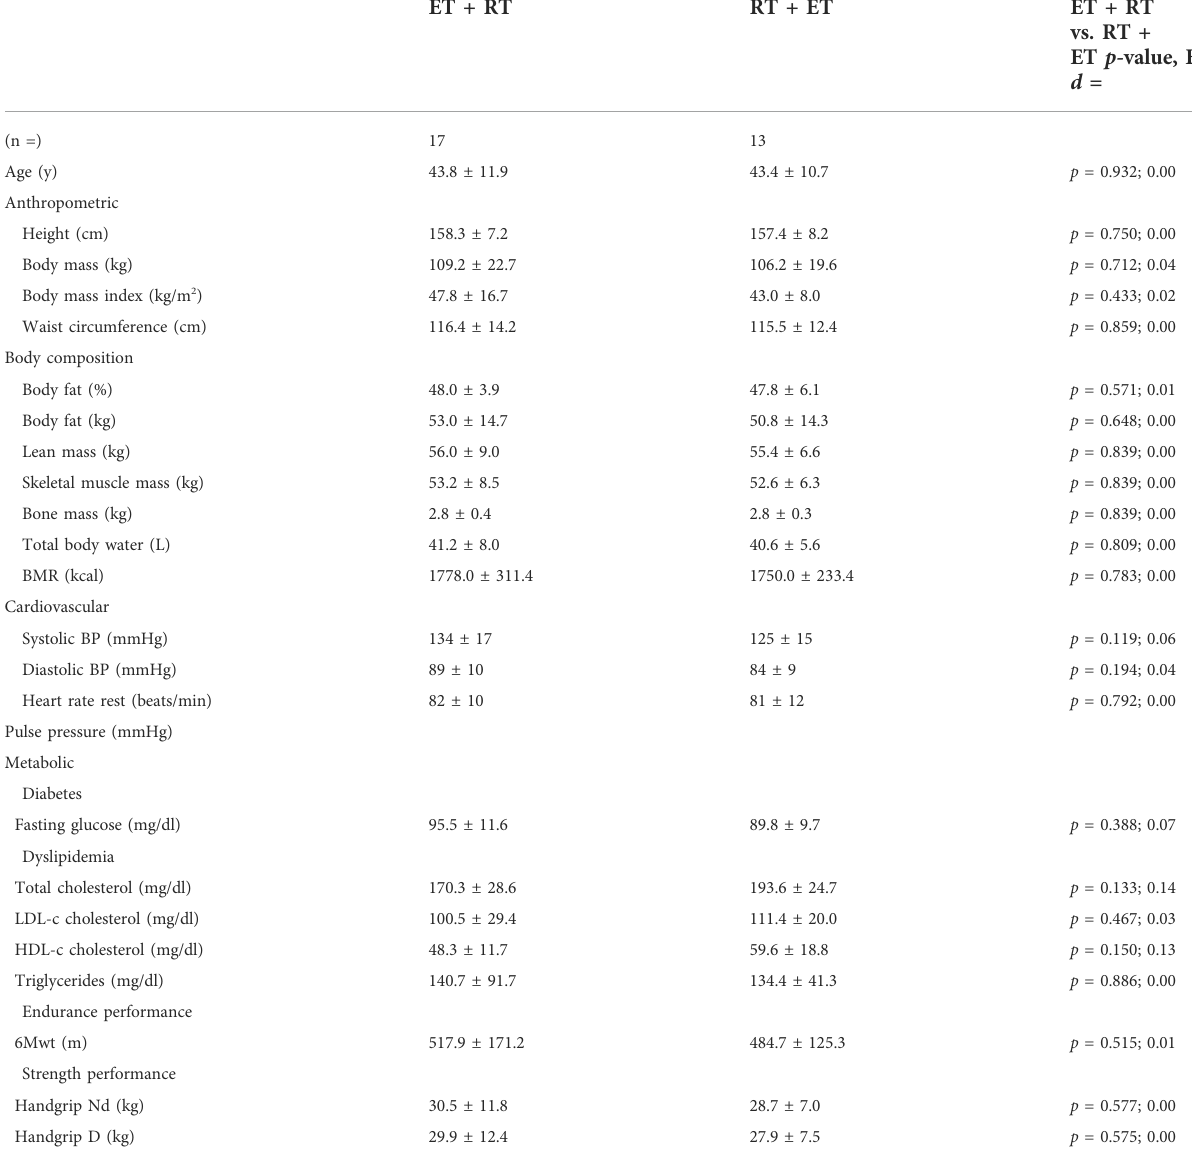
TABLE 1 Baseline characteristics of the